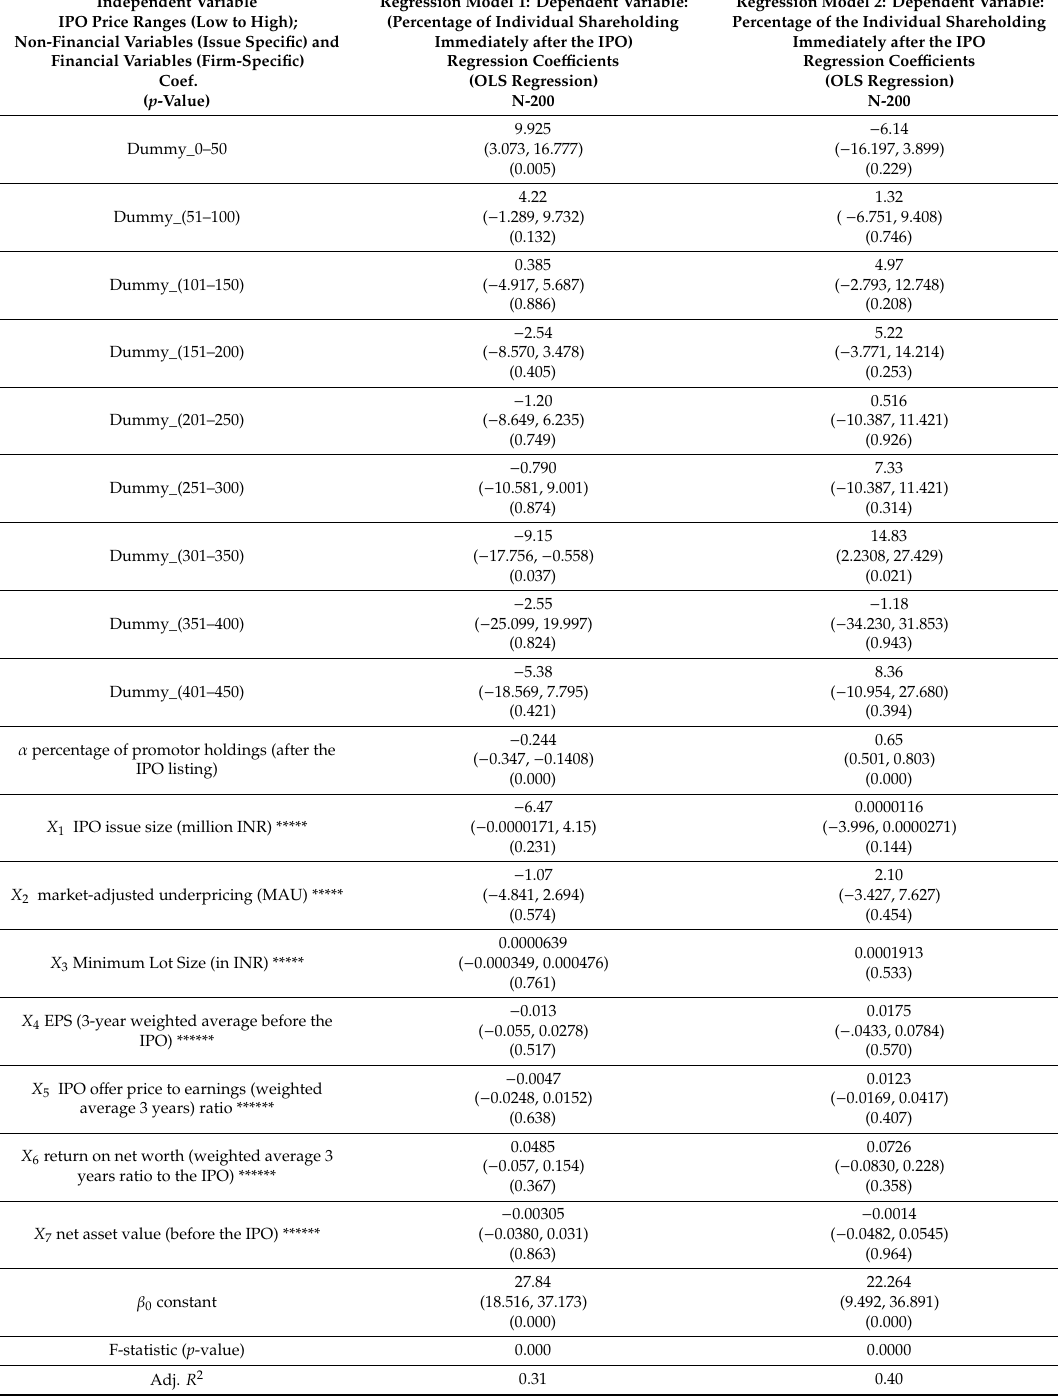
Table A3. Results of OLS regressions. The e ff ect of IPO o ff ers price ranges and financial and IPO issue characteristics on post-IPO ownership structure between individual and institutional investors. The regression model is checked for multicollinearity among the reession variables. Independent Variable IPO Price Ranges (Low to High); Non-Financial Variables (Issue Specific) and Financial Variables (Firm-Specific)